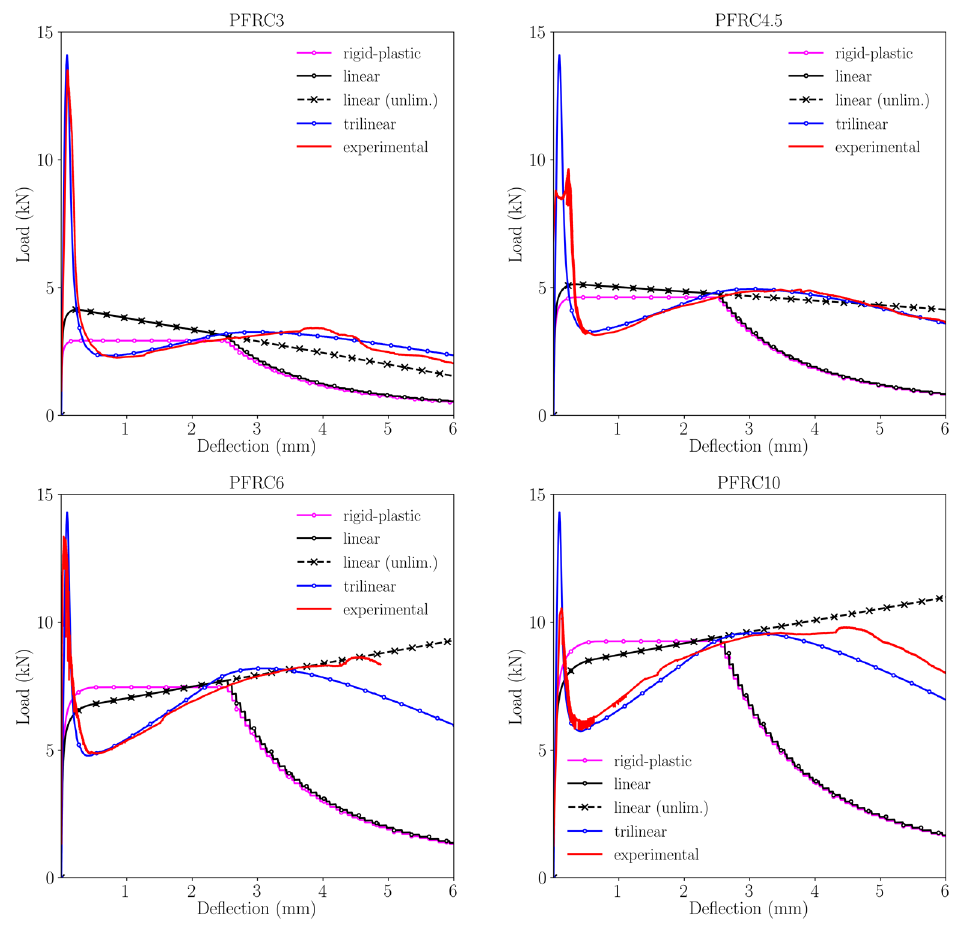
Figure 8. Comparison among the experimental curves and the simulations results obtained with the constitutive models implemented. constitutive models